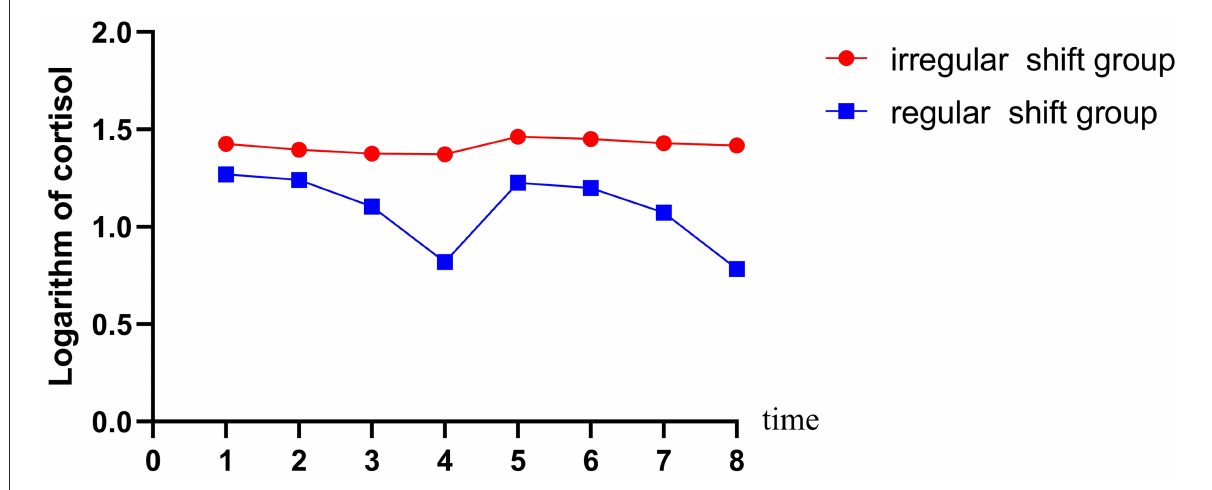
FIGURE1 Diurnal pattern of cortisol secretion according to shift work at baseline. 1 = 30min after waking on the first day; 2 = 11:00 on the first day; 3 = 19:00 on the first day; 4 = 23:00 on the first day; 5 = 30min after waking on the second day; 6 = 11:00 on the second day; 7 = 19:00 on the second day; 8 = 23:00 on the second day. The blue line represents cortisol pattern for midwives with regular shifts ( N = 43). The red line represents cortisol pattern for midwives with irregular shifts ( N = 43).